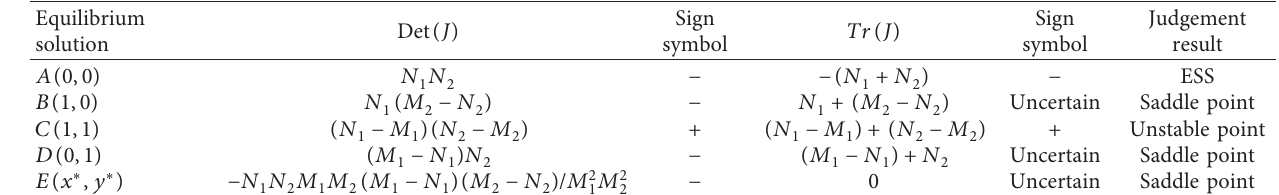
< N and M < N . 1 1 2 2